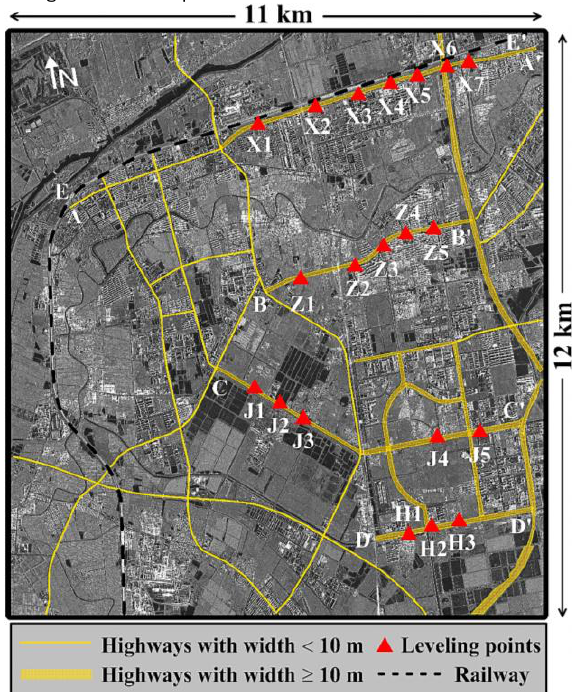
Fig. 1 Location map of the study area